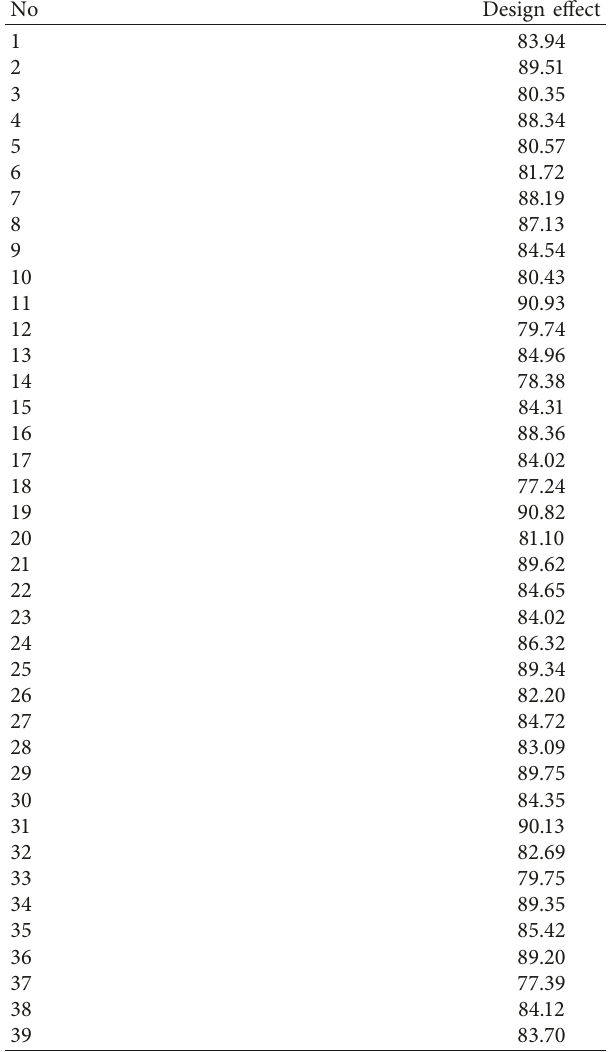
Table 1: The statistical table of the effect of jewelry art modeling design based on computer-aided